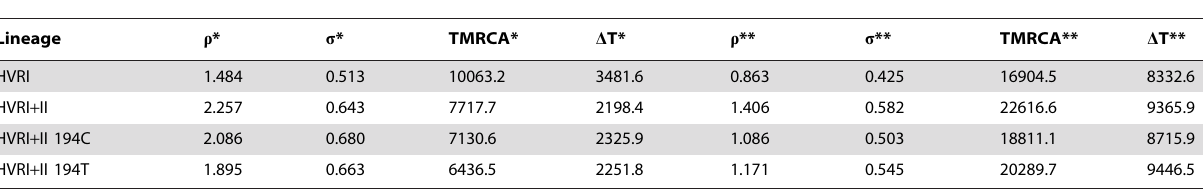
Table 2. r -statistics and TMRCA estimates for various root lineages.